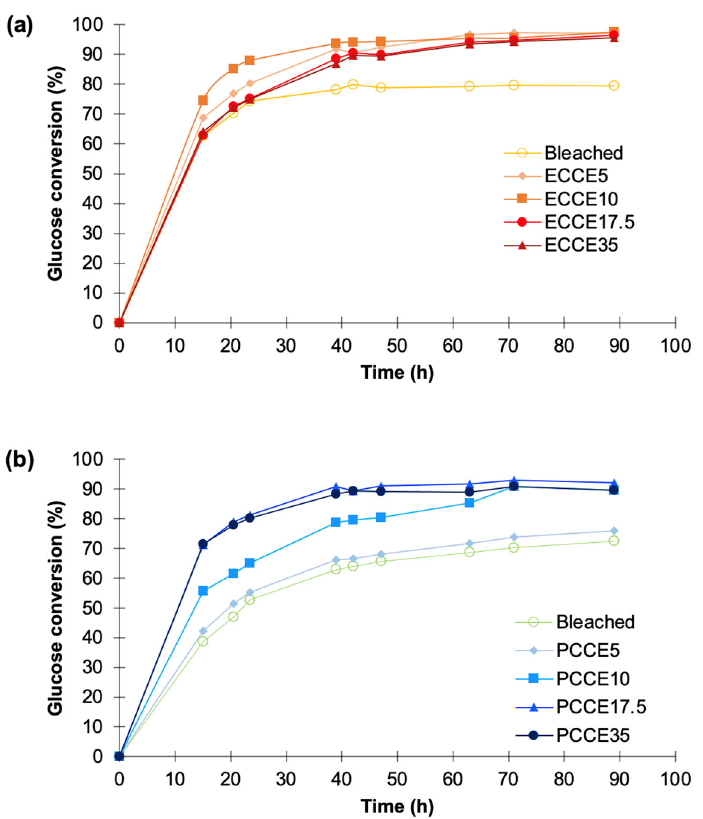
Figure 8. Enzymatic multicomponent (Cellic CTec3) hydrolysis of ( a ) eucalyptus and ( b ) pine fibers after CCE treatments.